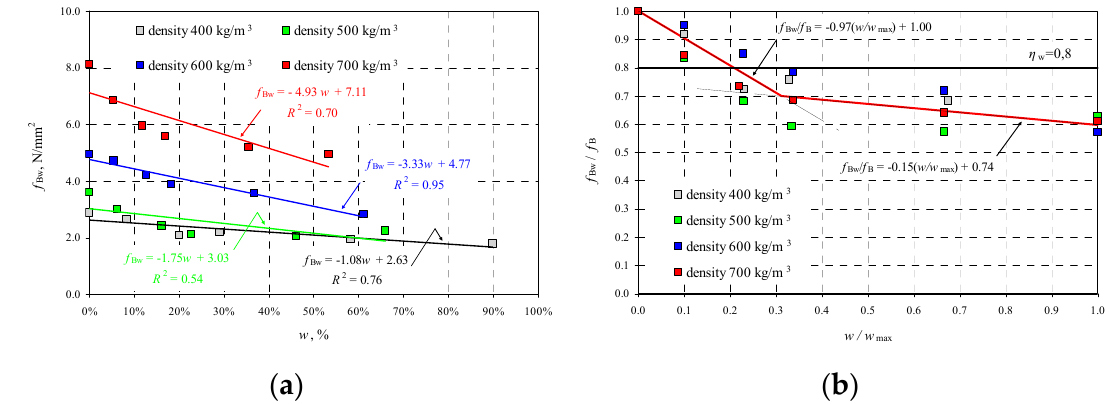
Figure 6. Test results for AAC strength, taking into account moisture level: ( a ) strength f Bw as a function of moisture w , and ( b ) relative strength of AAC f Bw / f B as a function w / w max.